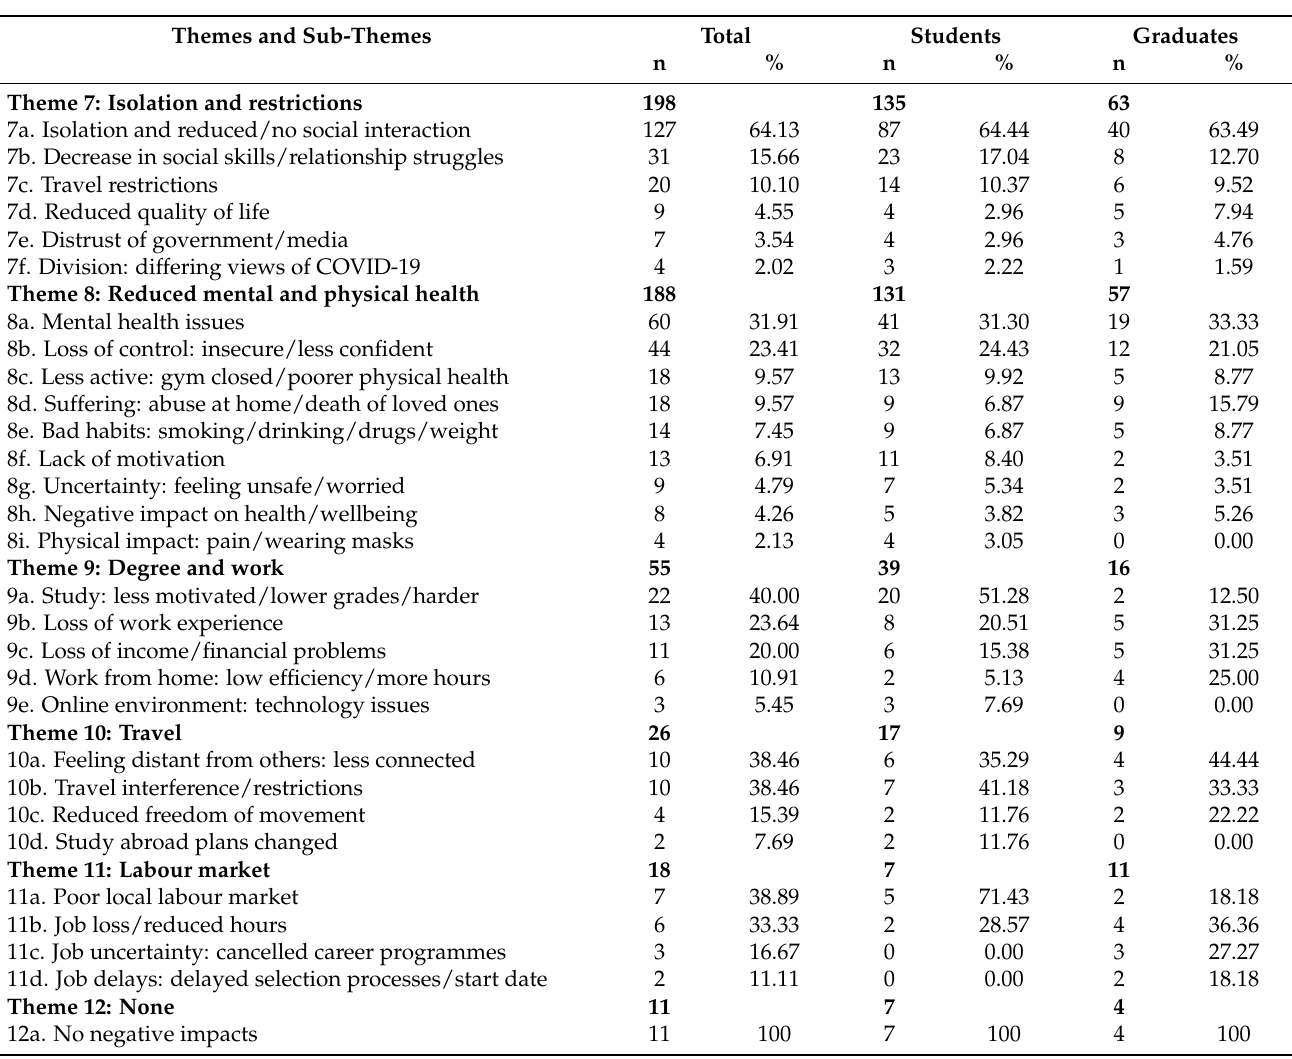
Table 7. Perceived negative impacts of COVID-19 on subjective wellbeing (n =